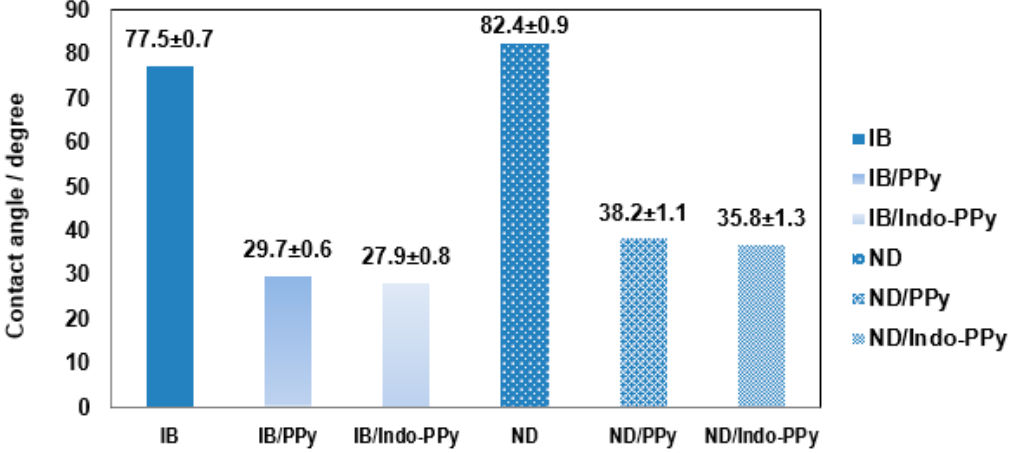
Figure 8. Contact angles of the bare NiCr investigated alloys, of the electrochemically synthesized PPy and PPy-Indo coatings.